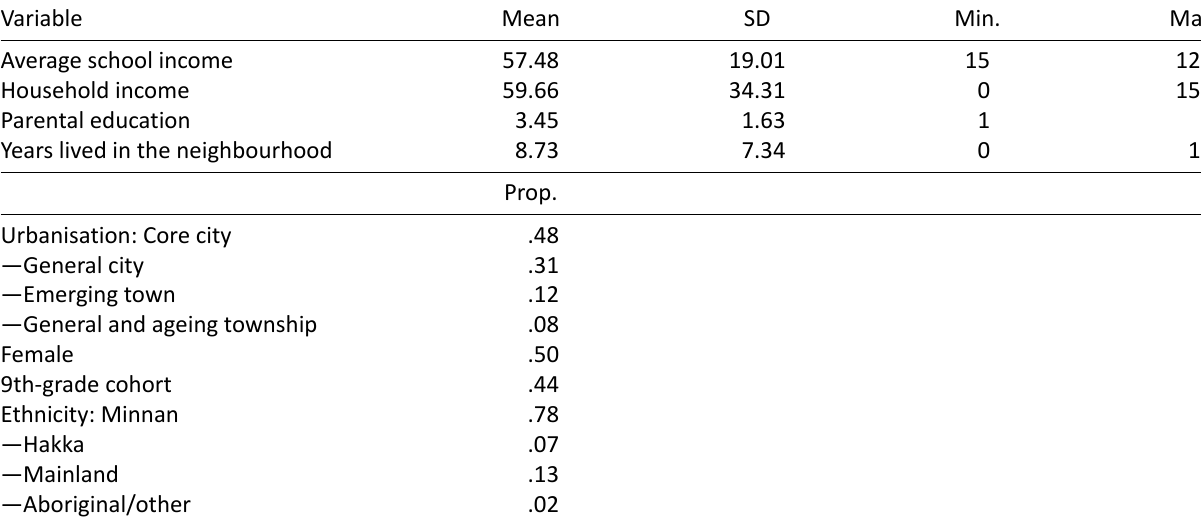
Table 2. Descriptive statistics (N =